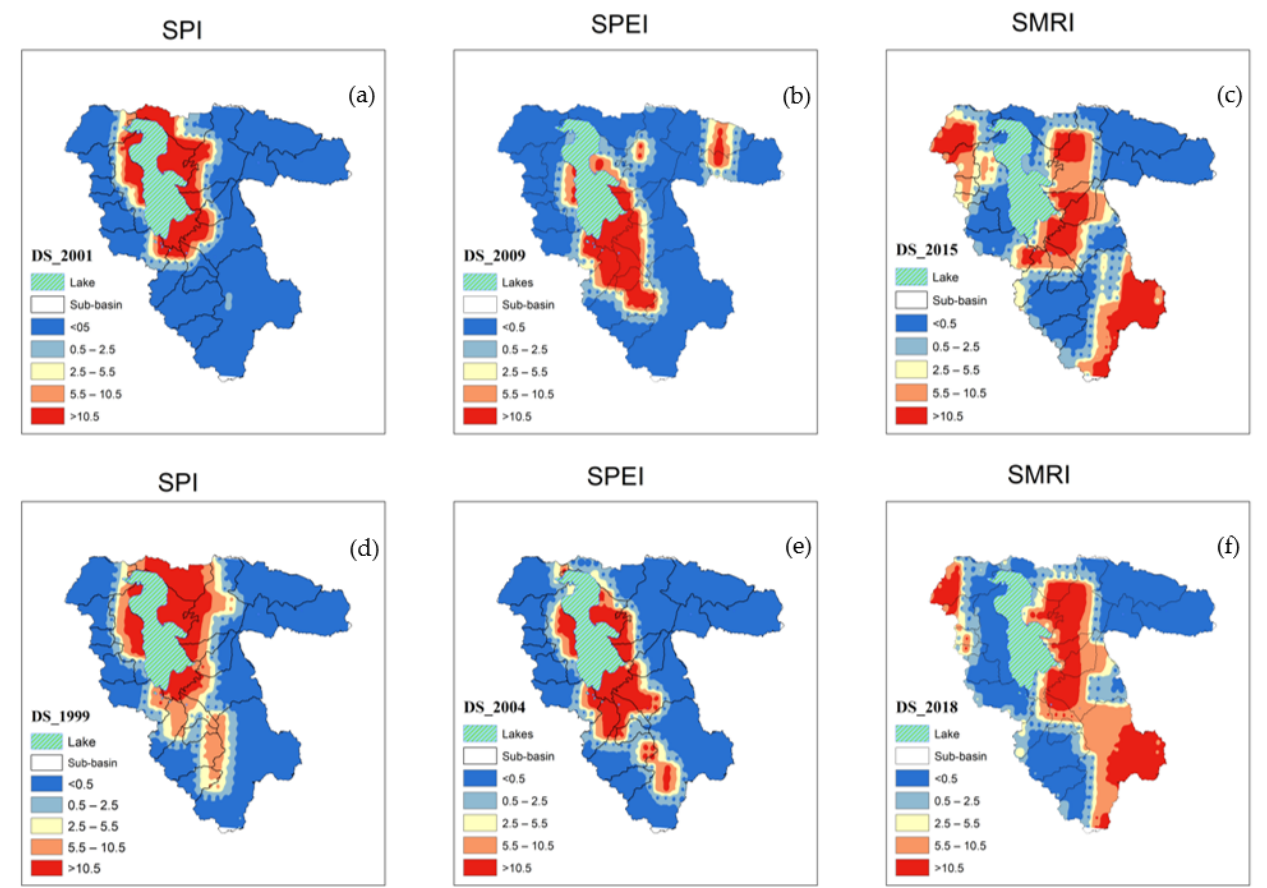
Water 2021 , 13 , x FOR PEER REVIEW 18 of 23